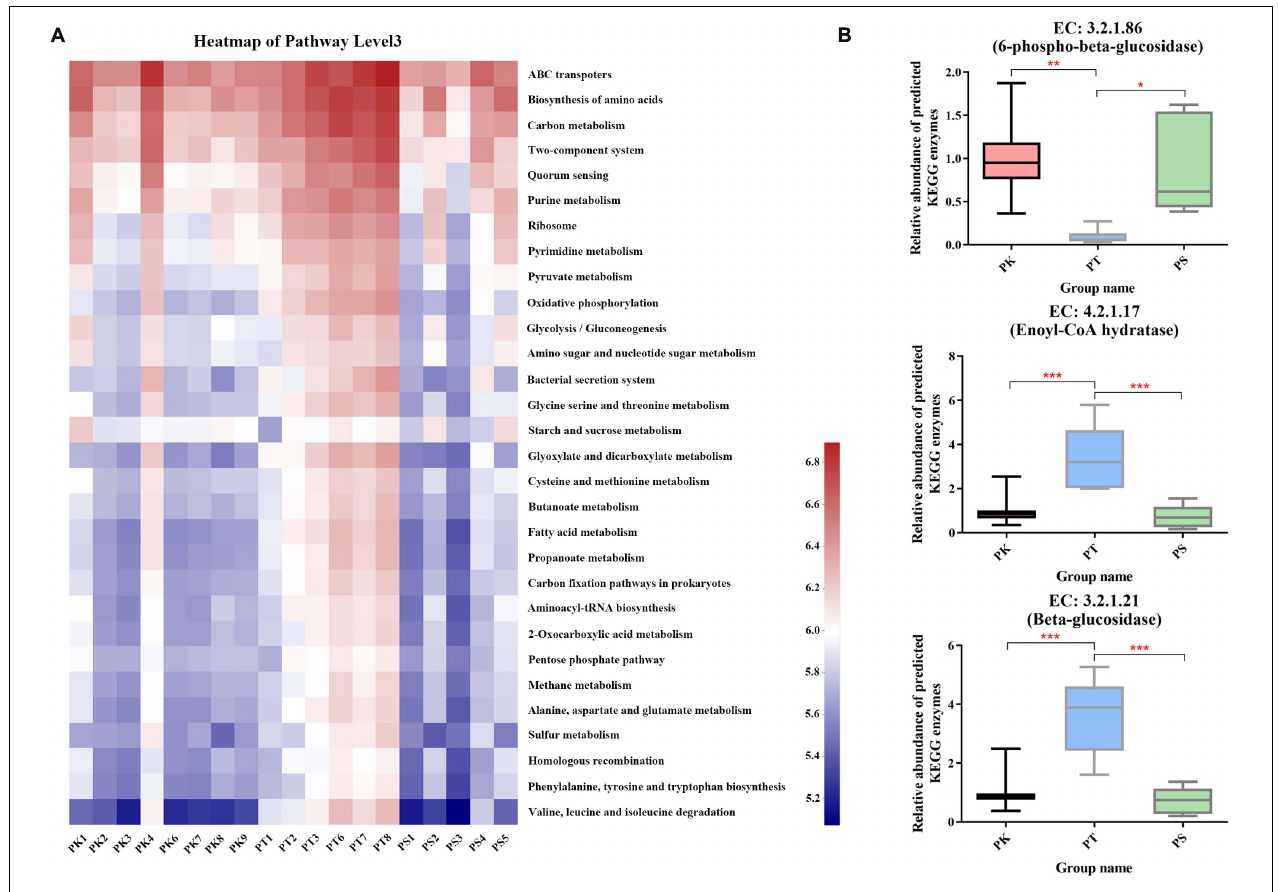
FIGURE 5 | Comparison of predicted KEGG ortholog group counts at level 3 and enzyme levels in different host tree species. (A) Heat map of the most abundant 30 categories at level 3; each column corresponds to an M. saltuarius sample, and each row corresponds to a specific category. (B) Relative abundance of three highly abundant predicted KEGG enzymes involved in cellulose or limonene and pinene degradation in the guts of larvae feeding on different host tree species (one-way ANOVA; * P < 0.05, ** P < 0.01, *** P <